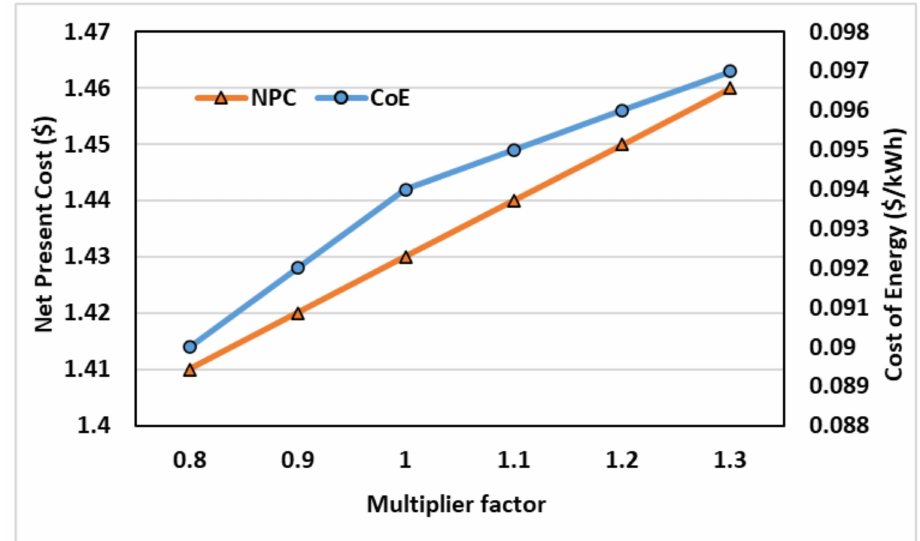
Figure 14. NPC and CoE of HRES with variations in battery